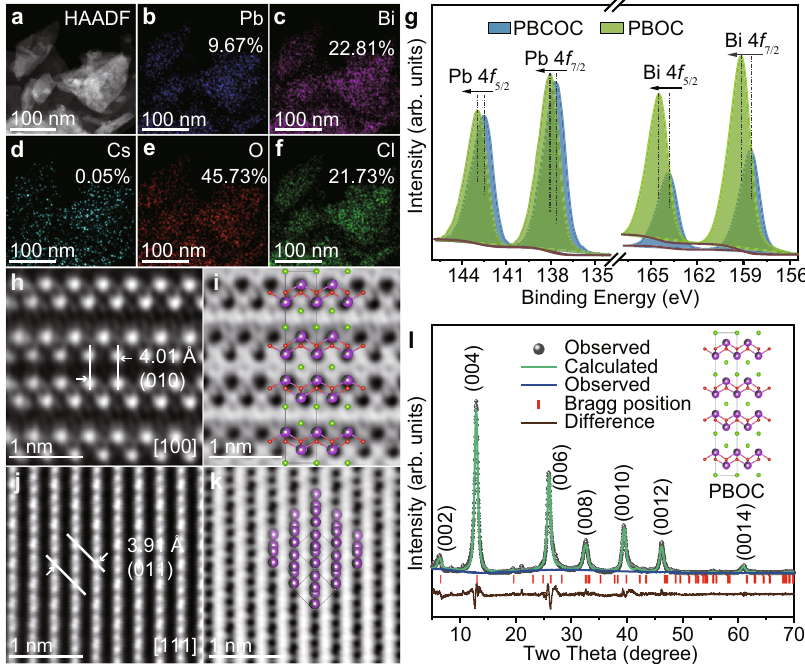
Fig. 2 Structure and composition of ultrathin PBOC layers. a − f STEM-EDS elemental-mapping images and the corresponding element atomic concentrations. g Bi 4 f and Pb 4 f spectra of ultrathin PBOC layer. h − k Atom-resolved inversed FFT HAADF- and BF- STEM images, with the labelled zone axis (O and Cl atoms are omitted for the sake of clarity in Fig. k ). l Le Bail fi tting results against PXRD